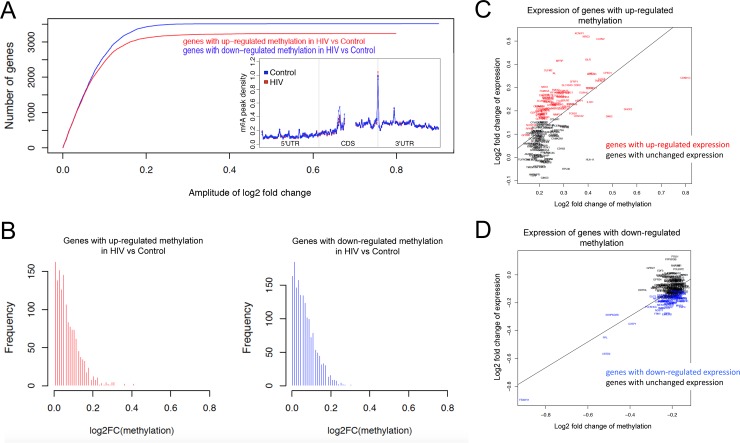
Distribution of genes with differential m6A RNA methylation in the hippocampus of HIV Tg rats.A) A larger number of genes with down-regulation of m6A methylation was observed in HIV Tg rats than the number of genes with up-regulated methylation, in particular, 201 genes with significant down-regulated methylation (p-value<0.05) while 172 genes were found with significant up-regulated methylation (p-value<0.05). Inset: Distribution of m6A peaks within hippocampal mRNAs of HIV Tg and control rat. Transcript architecture is shown underneath: 5’ untranslated region (UTR); coding sequence (CDS); and 3’ UTR. The density of m6A peaks was greater on the distal CDS and 3’UTR and showed the greatest enrichment in the immediate vicinity of the stop codon at the CDS-3’UTR boundary. B) The distribution of log2 fold change (log2FC) of genes with up-regulated and down-regulated methylation C,D) Correlation between the methylation and expression changes for genes with up-regulated and down-regulated methylation (Pearson correlation = 0.67 and 0.58 respectively). Among the 201 genes with down-regulated methylation, the expression of 127 genes are also down-regulated while the rest remain unchanged; Among the 172 genes with up-regulated methylation, the expression of 83 genes are also up-regulated while expression of 89 genes remain unchanged.